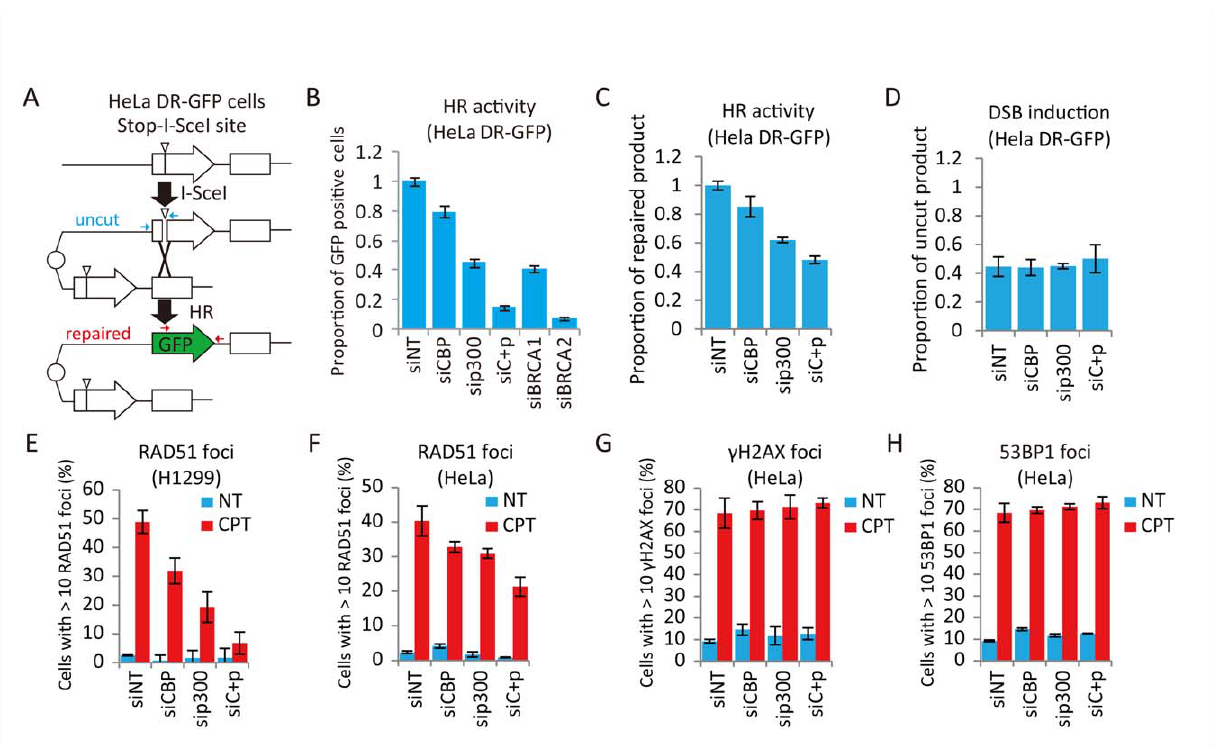
Figure 1. Involvement of CBP and p300 in HR. ( A ) HR Assay design. I- Sce I sites are indicated by white triangle heads. The locations of the PCR primers used for quantitative PCR to monitor DSB introduction by I- Sce I (uncut DNA) and the subsequent repair (repaired DNA) are indicated by blue and red arrows, respectively. (B) Suppression of I-Sce I-induced HR upon CBP and p300 depletion. HeLa DR-GFP cells, after transfection for 48 hr with non-targeting (siNT), CBP (siCBP), p300 (sip300), CBP + p300 (siC + p), BRCA1 (siBRCA1), or BRCA2 (siBRCA2) siRNAs, were transfected with an I-Sce I expression plasmid or mock-transfected. Forty-eight hours after transfection, cells were harvested and assayed for GFP expression by flow cytometry. Data represent the mean 6 SD. ( C, D ) Assessment of DSB generation and DNA repair. (C) Proportion of repaired product 48 hr after transfection of the I- Sce I expression plasmid. The proportion of repaired product detected after targeting siRNA treatment is expressed as a ratio to that detected after non-targeting siRNA (siNT) treatment. (D) Proportion of uncut product at the I- Sce I site 24 hr after transfection of the I- Sce I expression plasmid. The proportion of uncut product is expressed as a ratio to the amount of uncut product present before I- Sce I expression plasmid transfection. Data represent the mean 6 SD. ( E, F, G, H ) Suppression of CPT-induced foci formation upon depletion of CBP and/or p300. HeLa or H1299 cells were transfected with non-targeting (siNT), CBP (siCBP), p300 (sip300), or CBP + p300 (siC + p) siRNAs for 48 hr. Cells were then treated with DMSO (NT) or 1 m M camptothecin (CPT), fixed and processed for immunofluorescence detection of RAD51 (E, H1299; F, HeLa), c H2AX (G, HeLa), or 53BP1 (H, HeLa). Data represent the mean 6 SD.